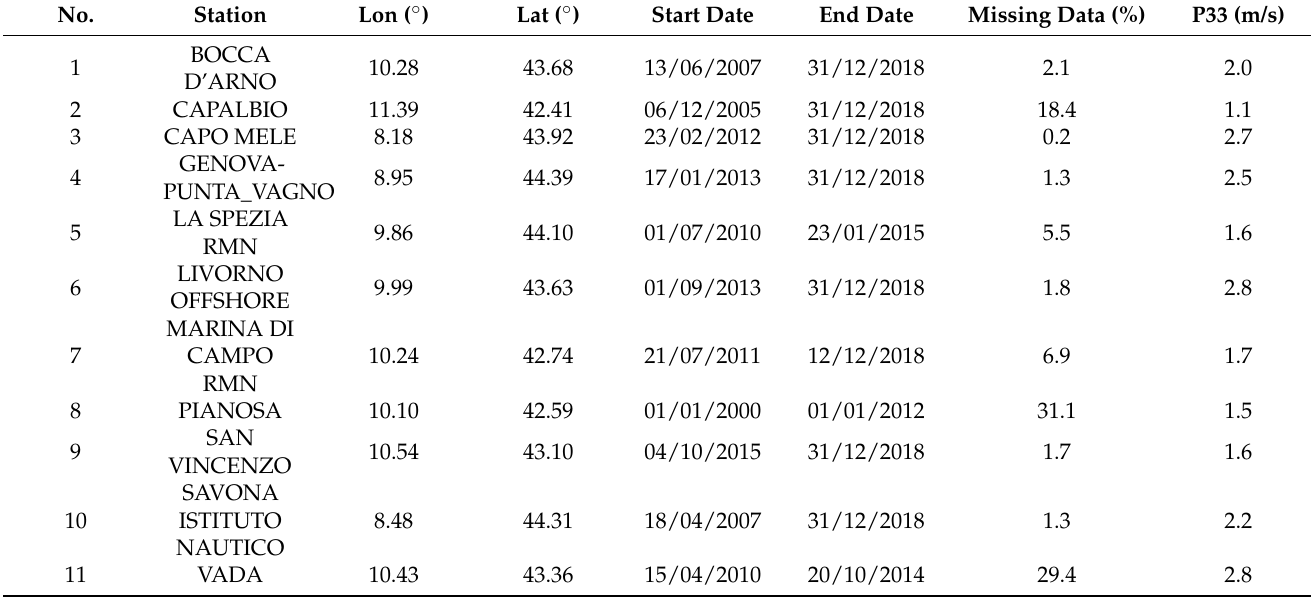
Table 2. Wind stations with locations, time periods used to validate model data, and percentages of gaps in the mean wind velocity (V)